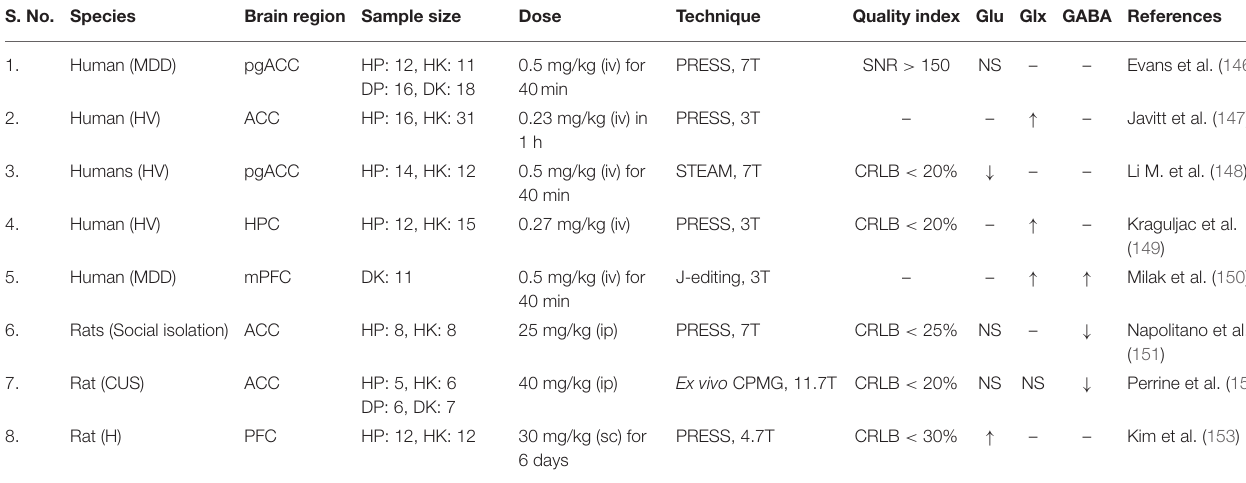
TABLE 3 | Impact of ketamine on neurometabolites homeostasis in